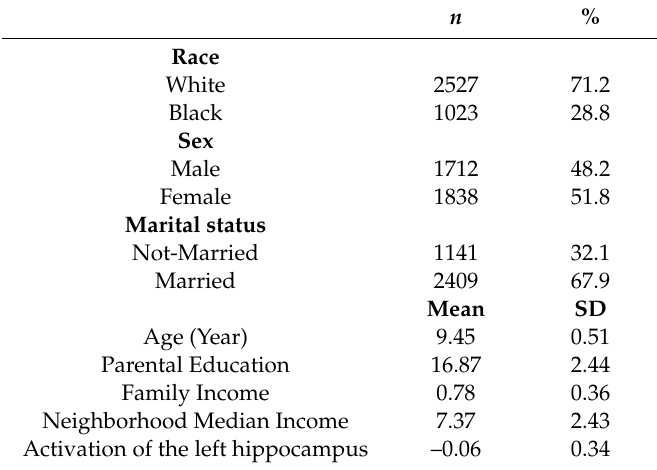
Table 1. Descriptive data overall (n = 3067).